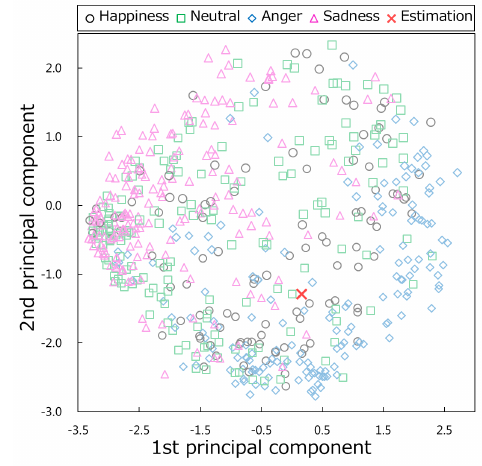
Figure 6: Generated emotional representation of multimodal ex- pressions from the example data (Fig. 5a) in the PC1-2 space, which is acquired by Experiment I (Fig. 4a). The estimation is plotted by the red